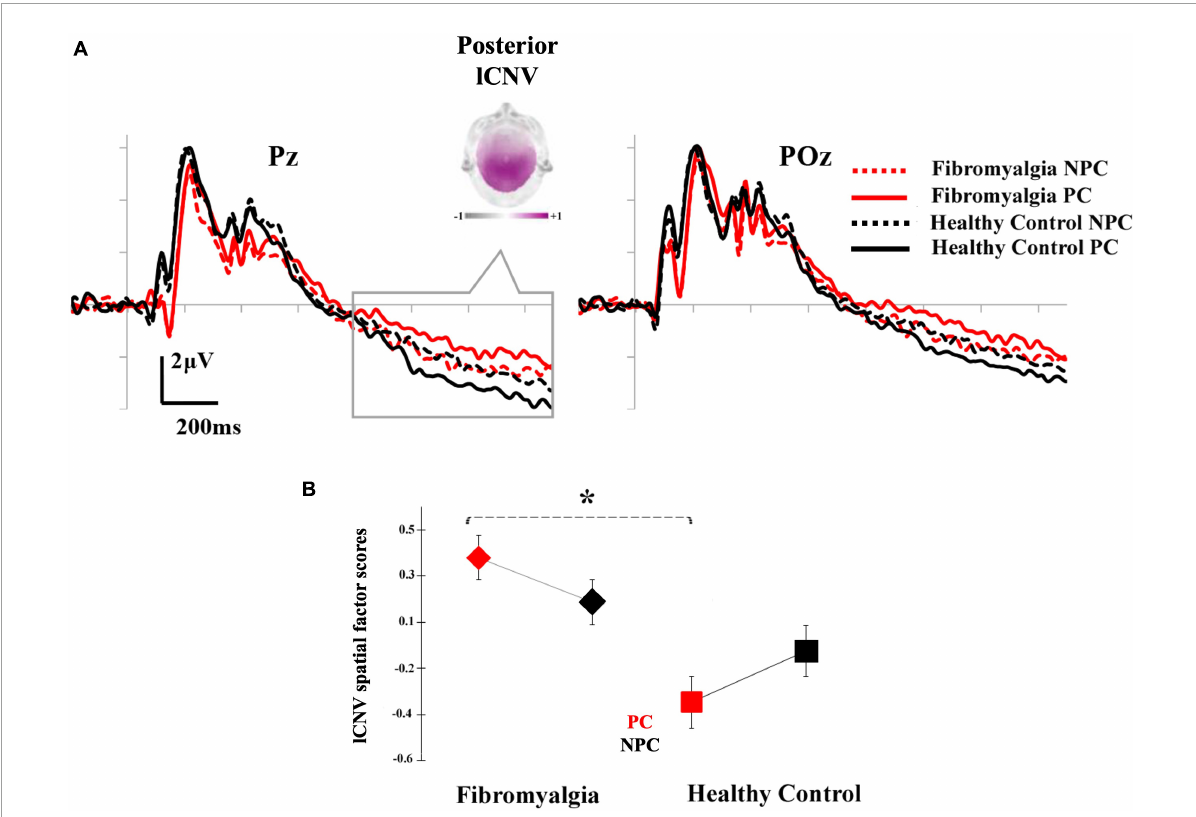
FIGURE3 Grand averages of the expectation period: (A) ERP waveforms for fibromyalgia patients (red) and healthy control participants (black) in response to PC (solid lines) and NPC (dashed lines) at the posterior selected electrodes (Pz and POz). The time window (800–1,500 ms, gray rectangle) and topographic map of lCNV are also highlighted; and (B) means of the lCNV spatial factor scores (posterior region) for fibromyalgia (left) and healthy control participants (right) in PC (red) and NPC (gray) conditions. Asterisks show the comparison in which significant differences were found. Bars show the standard error (* p < 0.05). (PC, pain cue; NPC, no pain